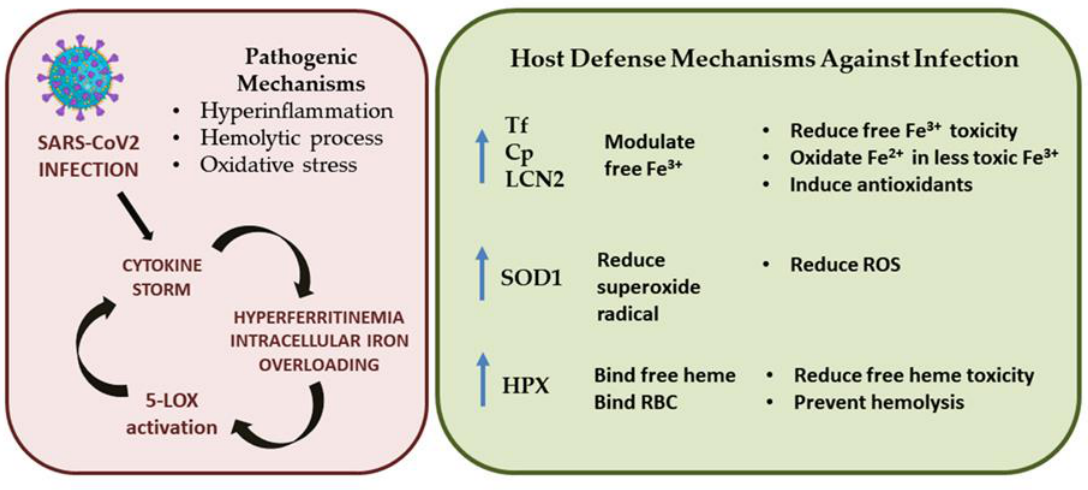
Figure 5. Schematic representation of pathogenesis of SARS-CoV-2 infection and possible defense mechanisms.